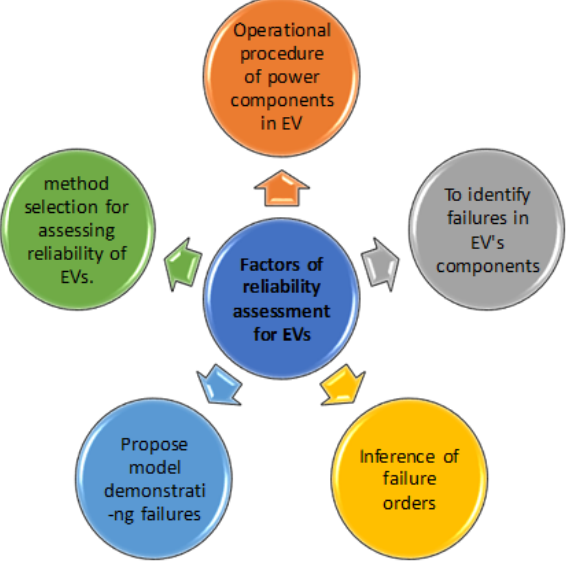
Figure 7. Significant factors concerning the reliability assessment of EVs.